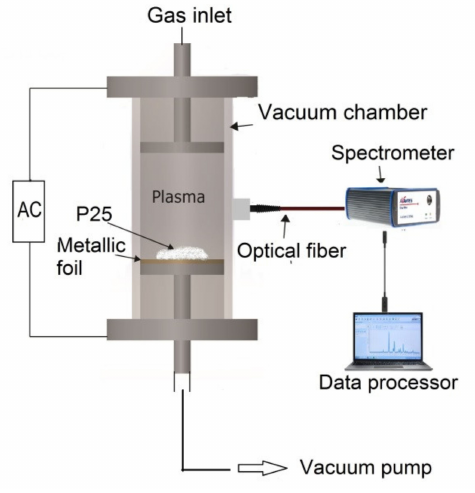
Figure 1. Schematic arrangement of the plasma